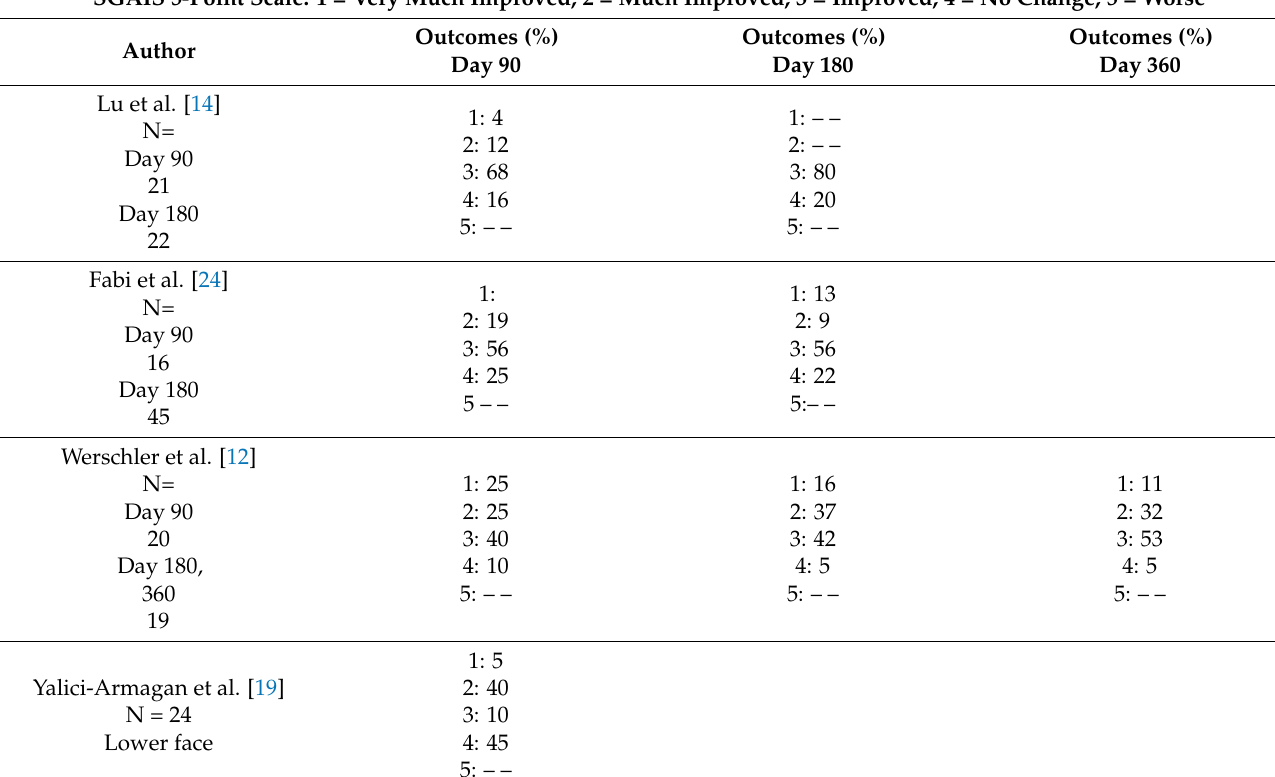
Table 5. Subject Global Aesthetic Improvement Scale (SGAIS) and pooled subjective